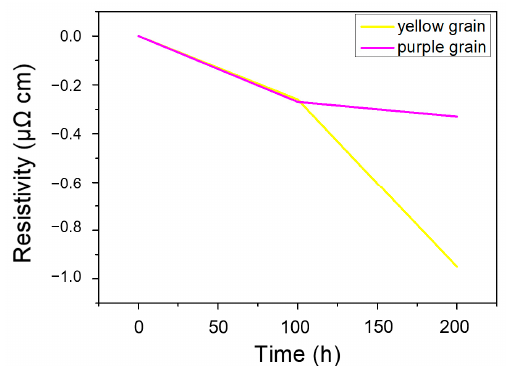
Figure 4. The resistivity evolution of the yellow grain and the purple grain.